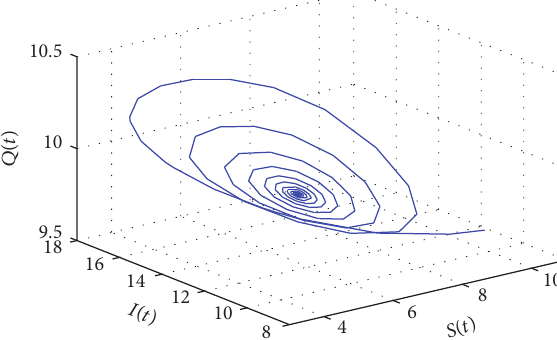
Figure 20: The phase plot of 𝑆 , 𝐼 , and 𝑄 when 𝜏 2 = 1.235 < 1.3485 = 𝜏 󸀠 20 and 𝜏 1 = 0.65 .